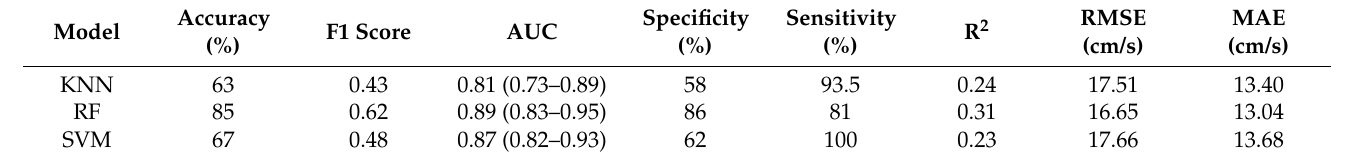
Table 4. Comparison of the predictive performance for three models in the testing